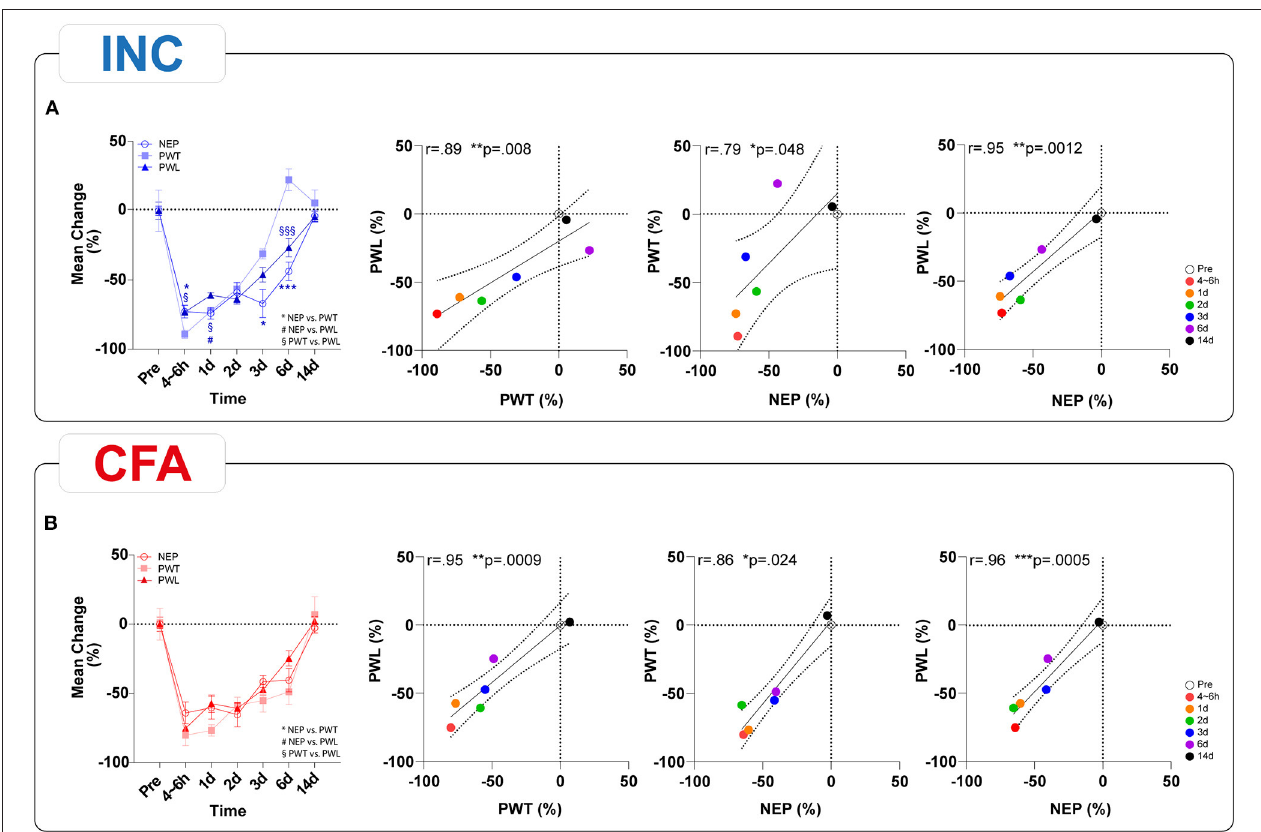
FIGURE 6 | Time-dependent correlation analysis of NEP behavior assessment and withdrawal reflex-based behavioral assays in INC (A) and CFA (B) animals. In both pain models, trajectories of PWT, PWL, and NEP were significantly correlated. The results are expressed as mean ± SEM. Values of p : * p < 0.05, ** p < 0.01, *** p < 0.001 NEP vs. PWT, # p < 0.05, ## p < 0.01, ### p < 0.001 NEP vs. PWL, § p < 0.05, §§ p < 0.01, §§§ p < 0.001 PWT vs. PWL, by Kruskal–Wallis and Dunnett’s multiple comparison tests. Linear regression (solid line) with 95% CI (dotted line) is displayed. Values of p : * p < 0.05, ** p < 0.01, *** p < 0.001 by Spearman (two-tailed) coefficients were used to determine relationships between multiple parameters. Correlation analyses were performed after first computing the mean of side-by-side replicates and then analyzing those